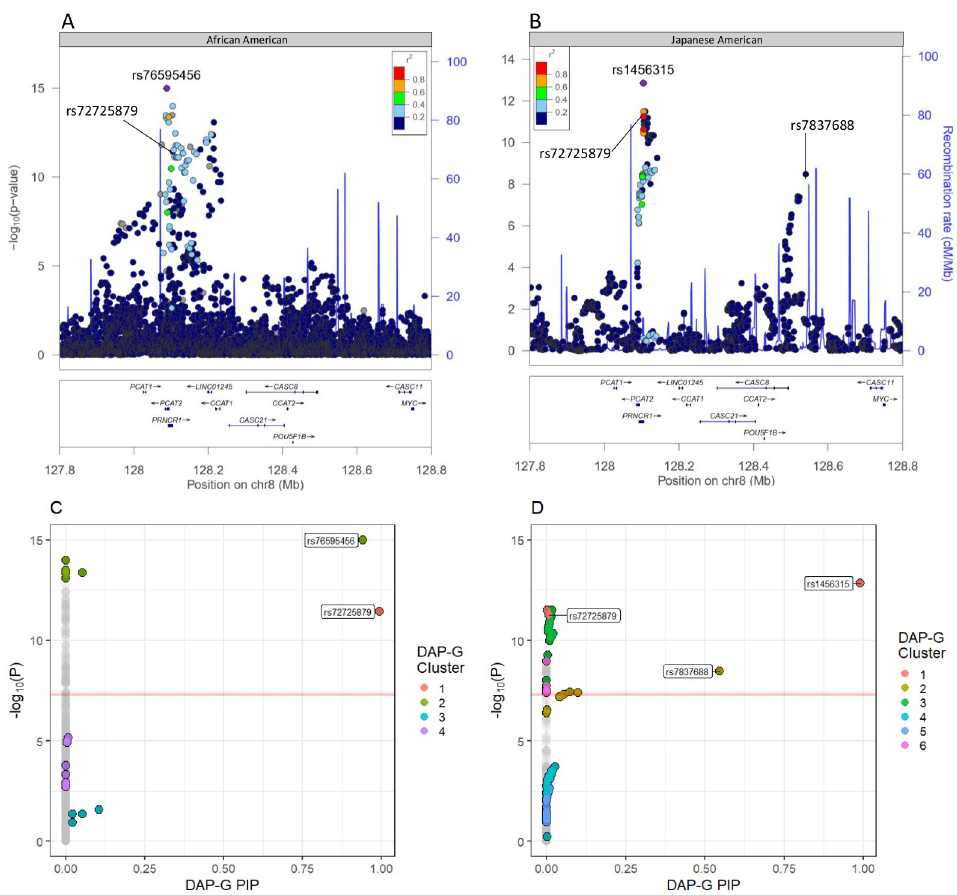
Fig 1. Fine-mapping of the top prostate cancer GWAS signals in African Americans and Japanese Americans. (A & B) depict a LocusZoom plots of GWAS results from African American and Japanese American populations, respectively [35]. The most significant SNPs in both GWAS were in the same chromosome 8 region. (A) is plotted using 1000G AFR 2014 LD, and (B) is plotted using 1000G ASN 2014 LD. The y-axis is the − log 10 (P) while the x-axis is location on chromosome 8 measured in megabases (Mb). Color represents the LD r 2 . (C & D) depict the GWAS − log 10 (P) compared to DAP-G SNP posterior inclusion probabilities (PIP) for the African American and Japanese American populations, respectively [20]. Each point on the plot represents one SNP in each GWAS. The color of each point represents the independent cluster the SNP was assigned to in its respective population. Grey points represent those that were not clustered by